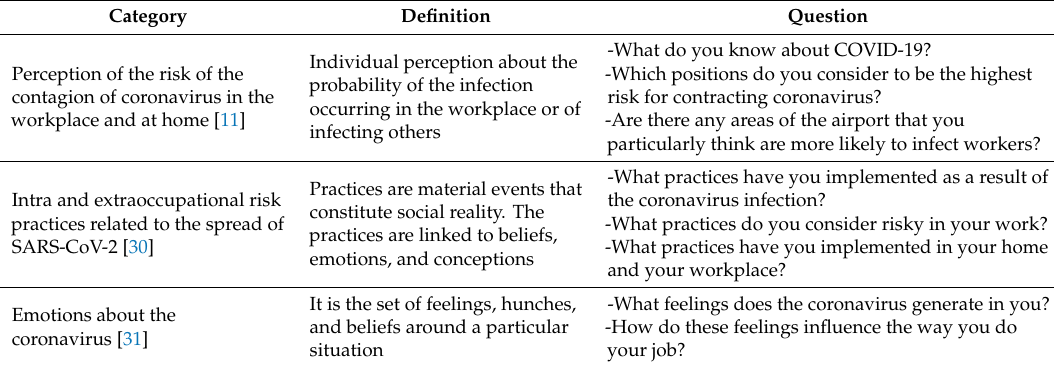
Table 1. Pre-established categories, definitions, and questions of the interview